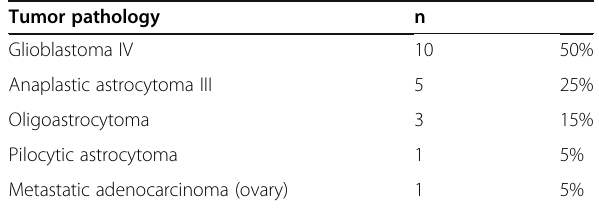
Table 3 Histopathological diagnosis Tumor